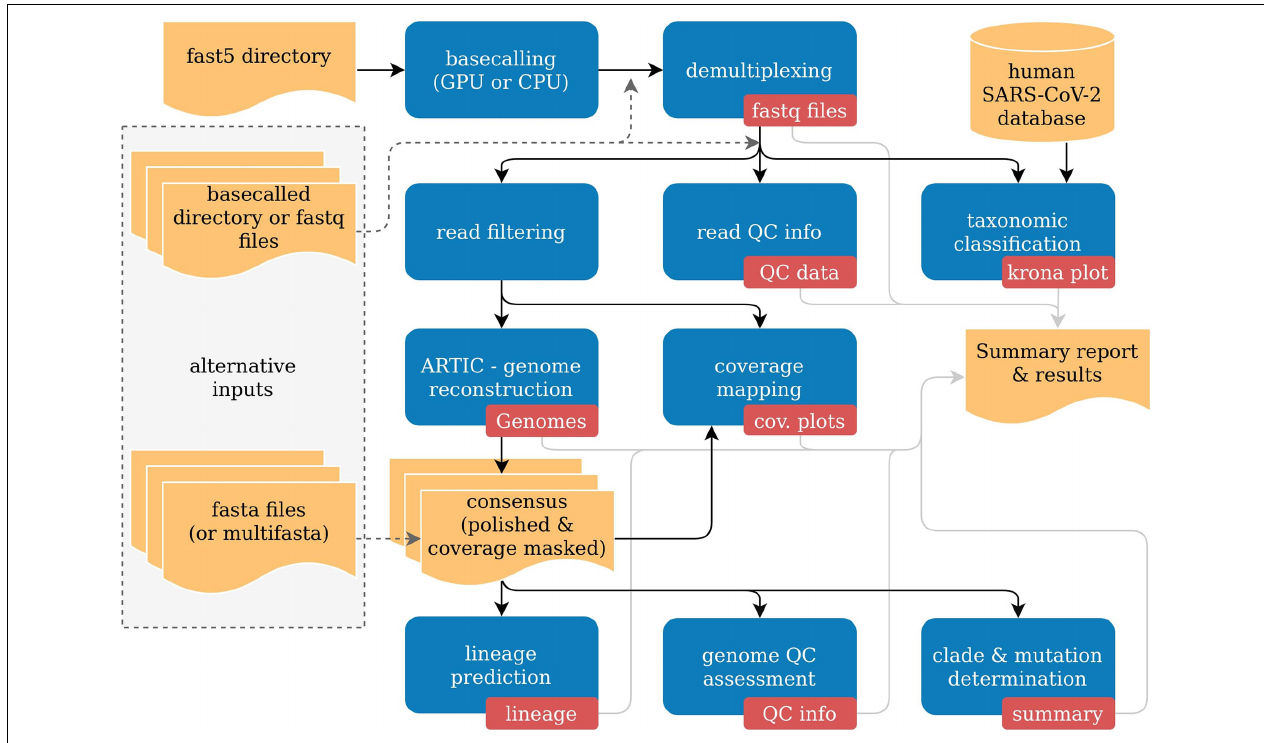
FIGURE 1 | Simplified overview of the poreCov workflow. Results and inputs are colored in yellow. Workflow processes are colored blue, and the resulting information of a process is red.